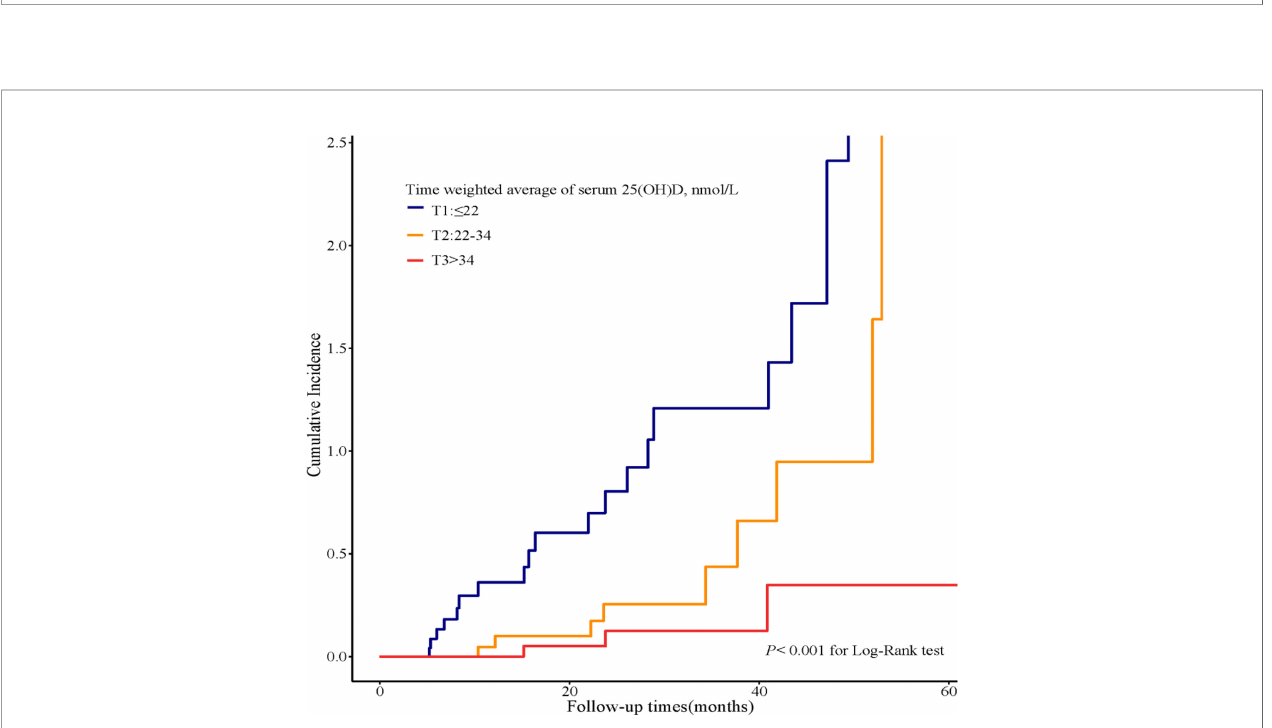
FIGURE 5 | Cumulative incidence of CKD progression in strata of tertiles of TWA of the serum 25(OH)D levels. Kaplan – Meier curves compare different strata of tertiles of TWA of the serum 25(OH)D levels in enrolled patients. TWA, time weighted average.